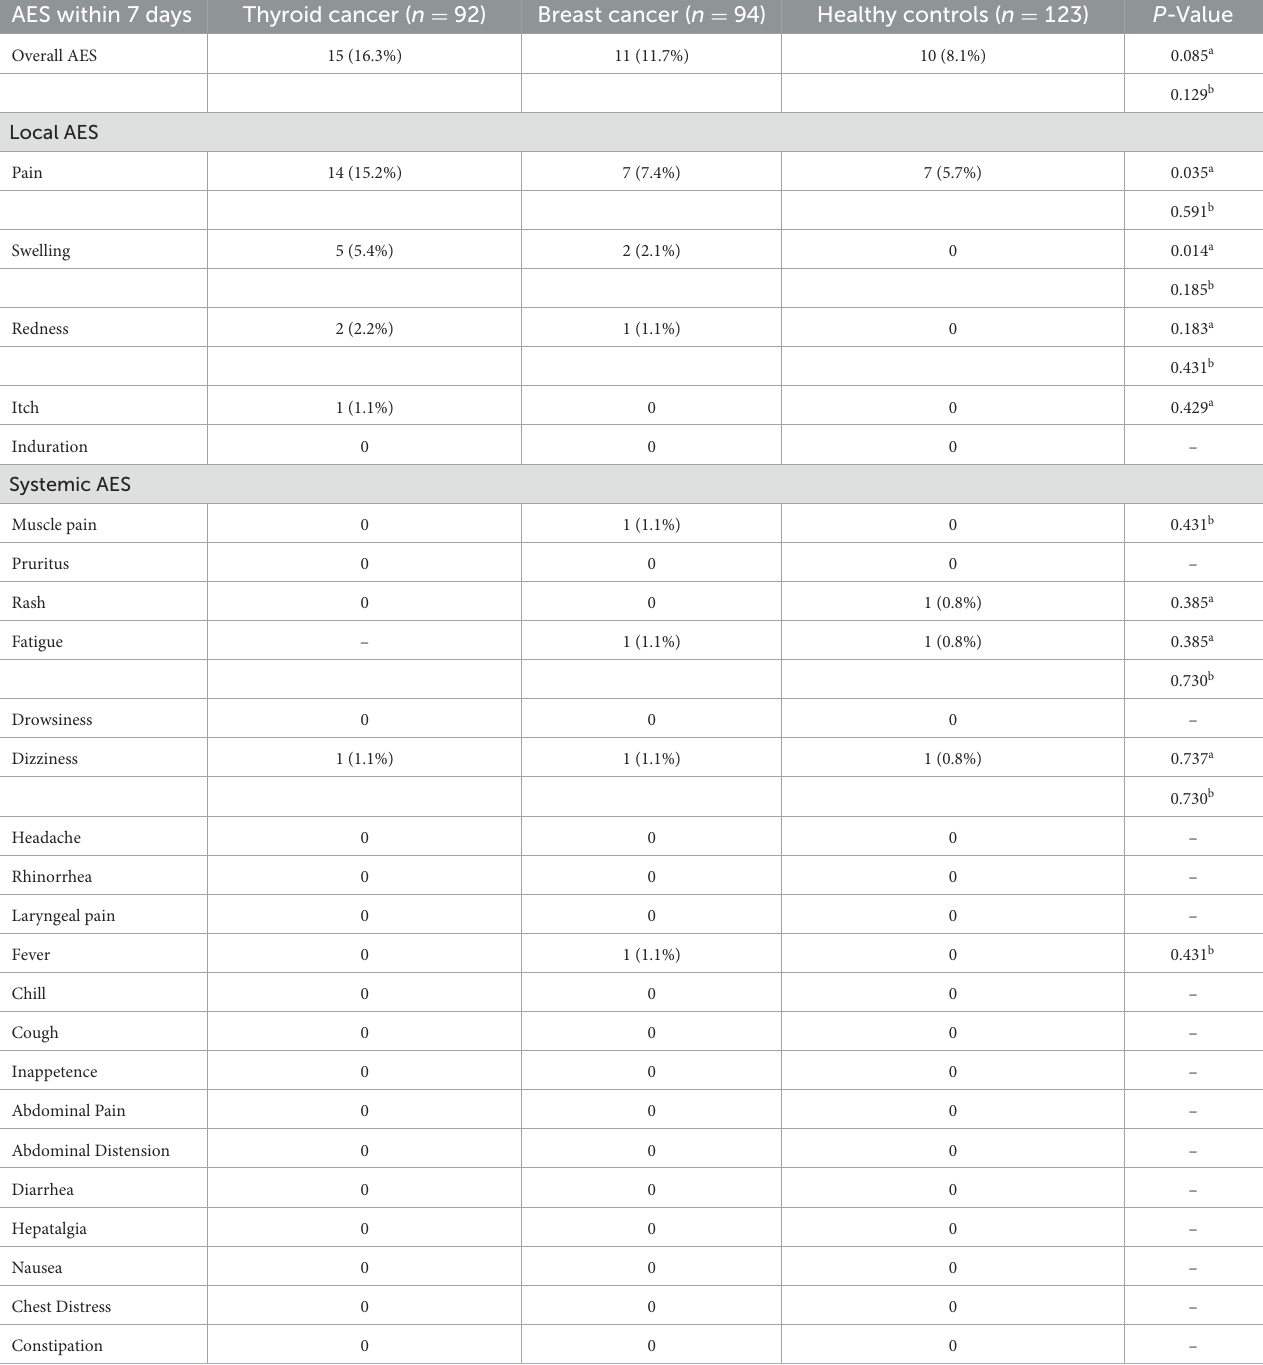
TABLE 4 Adverse events of COVID-19 vaccination in enrolled